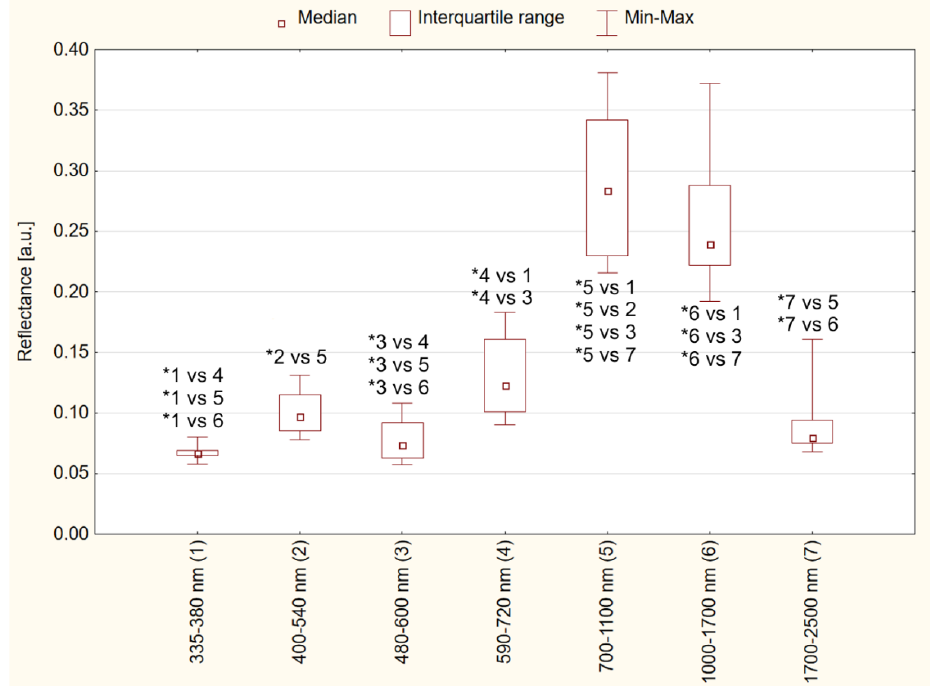
Figure 2. Chocolate reflectance values at different wavelength ranges; (1–7) wave range number. * p ≤ 0.05.